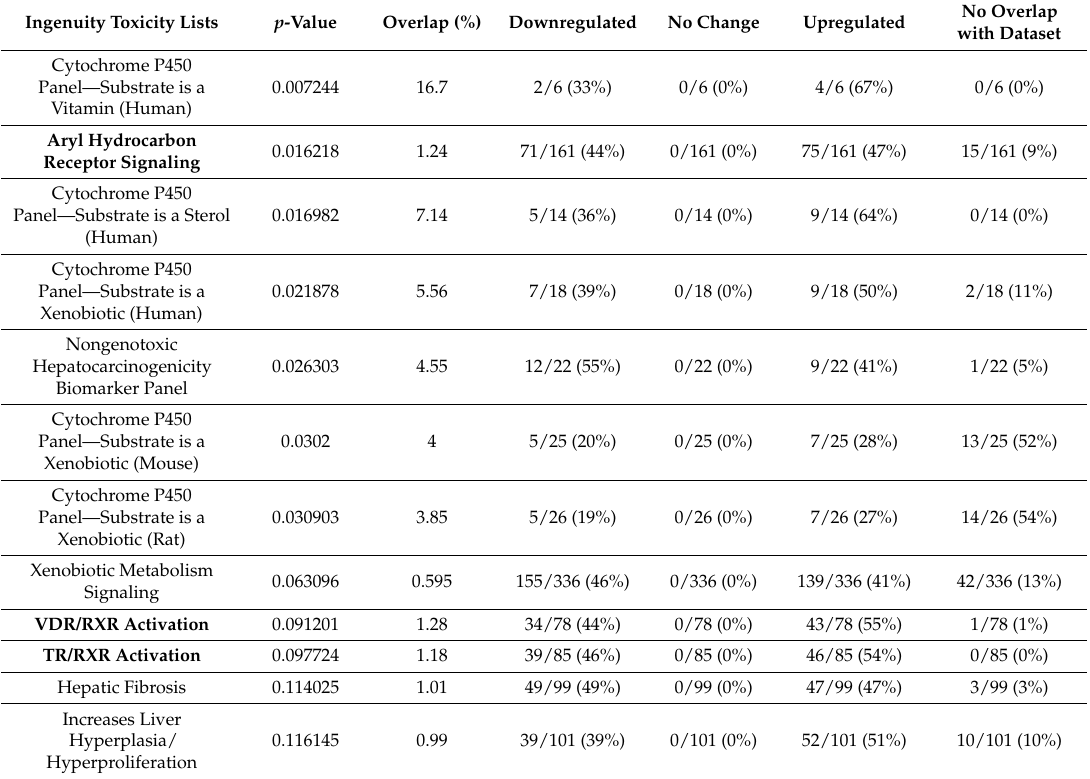
Table 5. Ingenuity toxicity list secondary to keratinocytes treatment with 20,23(OH) 2 D3 in humans for 6 h. Nuclear receptors are marked in